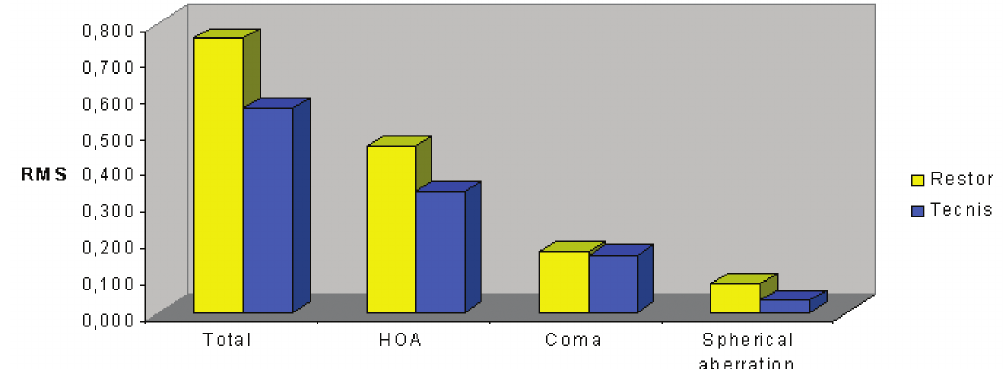
Figure 2 - Bar graph showing the wavefront data with a 5 mm pupil diameter for two diffractive multifocal intraocular lenses . The root-mean-square of the total aberration, the higher-order aberration (HOA) and coma aberration were not statistically different between the groups. The spherical aberration was significantly lower in the Tecnis group than in the ReSTOR group ( p =0.004)